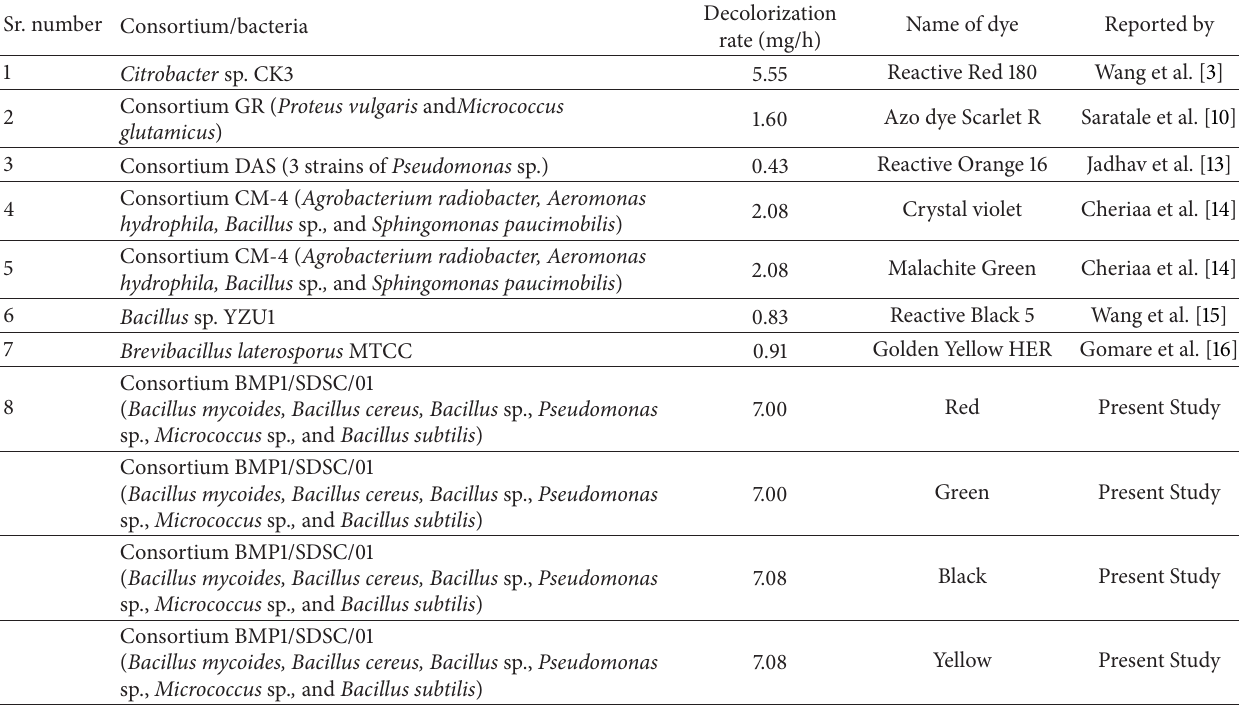
Table 3: Decolorization rate of different bacterial